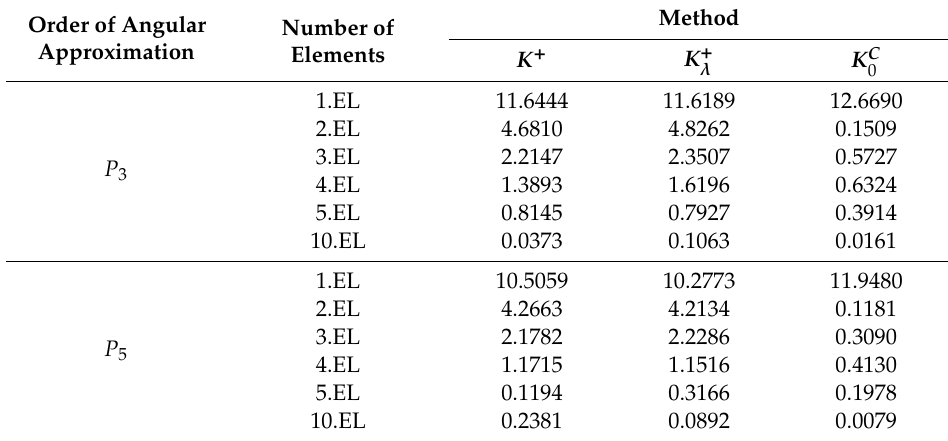
Table 4. Relative errors for P 3 , P 5 approximations with a set of elements for region 3. Order of Angular Approximation